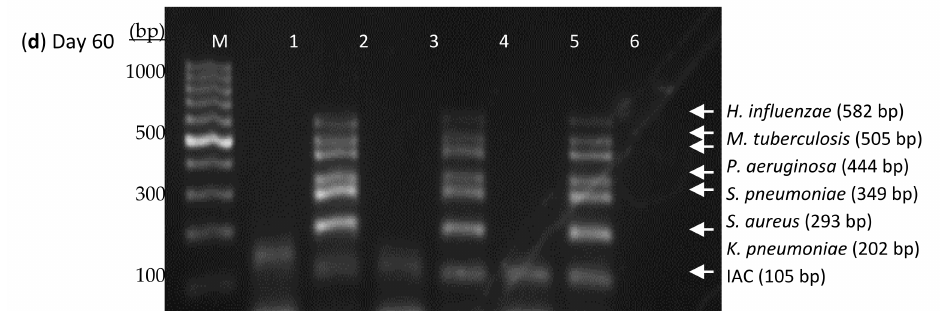
Figure 3. Stability evaluation of thermostabilized heptaplex PCR assay in the presence of 6% trehalose at 4 ◦ C, 25 ◦ C, 37 ◦ C, and 45 ◦ C on ( a ) Day 1, ( b ) Day 7, ( c ) Day 30, and ( d ) Day 60. Lane M: 100 bp DNA ladder; Lane 1: IAC at 4 ◦ C; Lane 2: PAC at 4 ◦ C; Lane 3: IAC at 25 ◦ C; Lane 4: PAC at 25 ◦ C; Lane 5: IAC at 37 ◦ C; Lane 6: PAC at 37 ◦ C; Lane 7: IAC at 45 ◦ C; Lane 8: PAC at 45 ◦ C. The dry-based PCR reagent was found to be stable at 4 ◦ C, 25 ◦ C, and 37 ◦ C for at least 60 days as tested in this